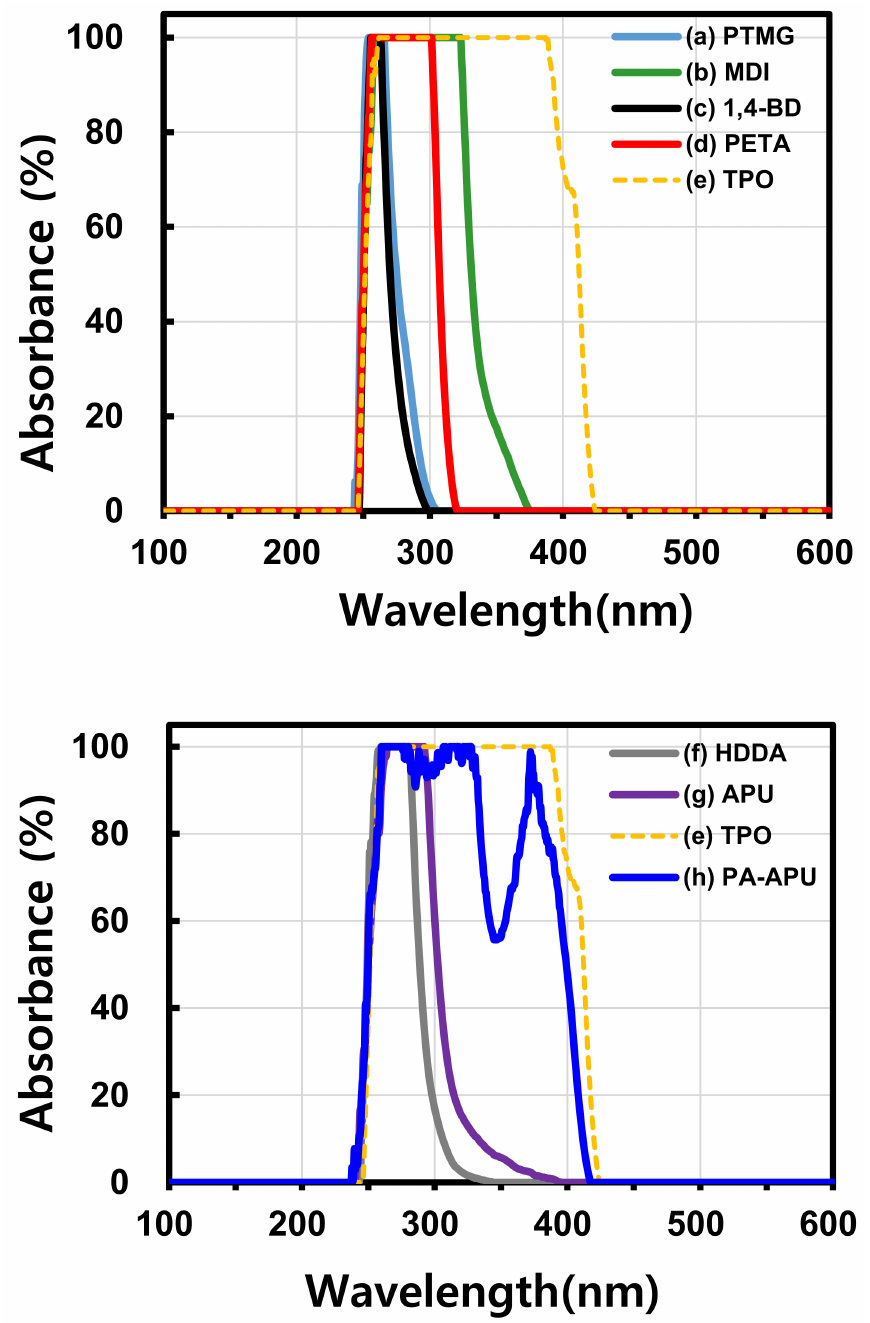
Figure 1. UV absorbance (AvaSpec-2048L): ( a ) PTMG, ( b ) MDI, ( c ) 1,4-BD, ( d ) PETA, ( e ) TPO, ( f ) HDDA, ( g ) APU: ( a )+( b )+( c )+( d ), ( h ) PA-APU: ( f )+( g )+( e